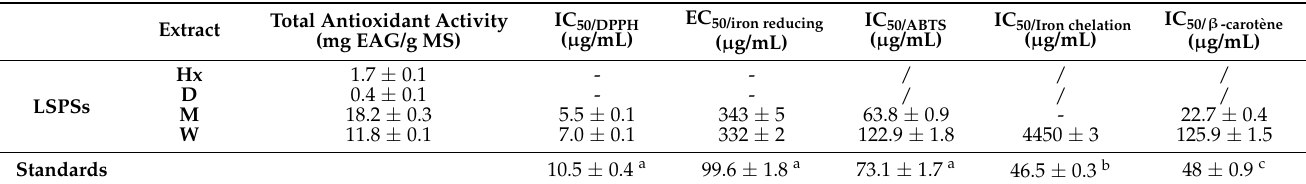
LSPSs: Leafy Stem of Phagnalon saxatile,/: not tested, -: IC50 value not achieved, Hx: Hexane, D: Dichloromethane, M: Methanol, W: water, a BHT, b EDTA, c